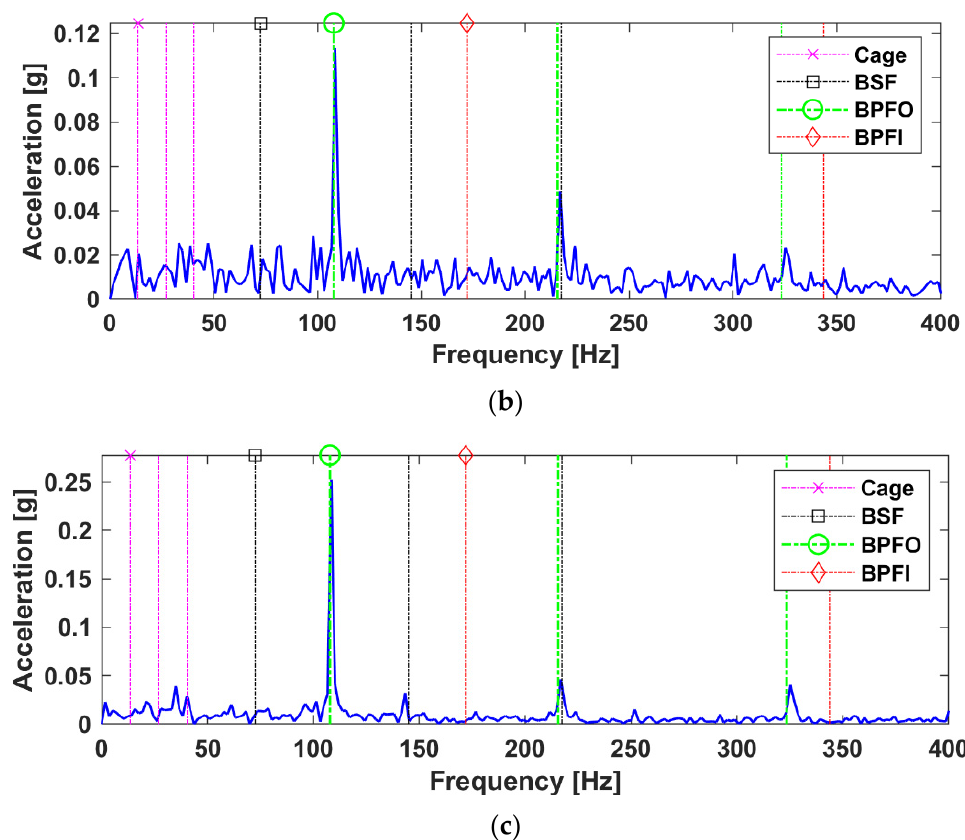
Figure 19. ( a – c ): The cross-spectra based on LRANTD fusion for Cases A to C. From Case A to Case C, the low-rank dimensions are, respectively, (3,4,2) , (4,4,2) , and (3,3,2) . 6.2. The Conventional Method For comparisons, the cross power spectral density (CPSD) of the envelope signals from two orthogonal acceleration measurements was calculated using the Welch’s averaged periodogram method with 90% overlap. The resulting spectra of Case A, B, and C are, respectively, shown in Figure 20 and adjusted to the same scale as those in Figure 19. For Case A and Case B, the BPFO component and its harmonics in the CPSD are interfered by other cyclic components, in particular the shaft rotation frequency, as marked by the red dots in Figure 20a,b.